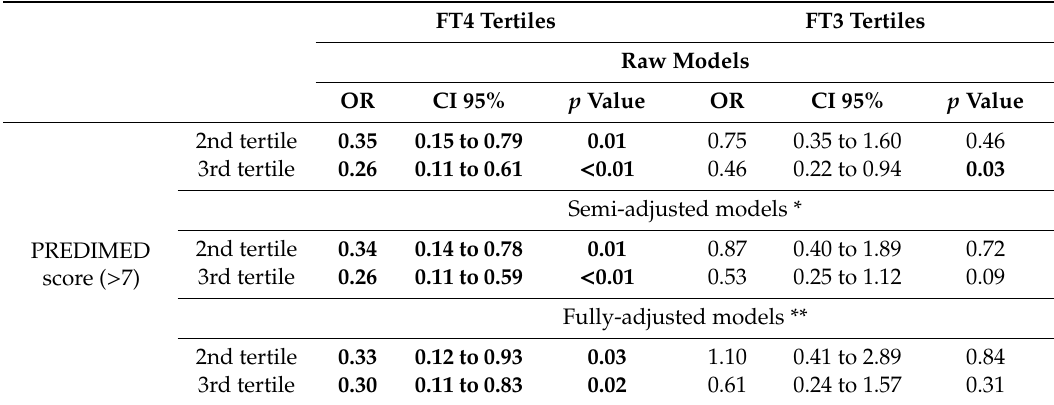
Table 2. Multinomial logistic regression models on FT4 and FT3 tertiles as dependent variables.